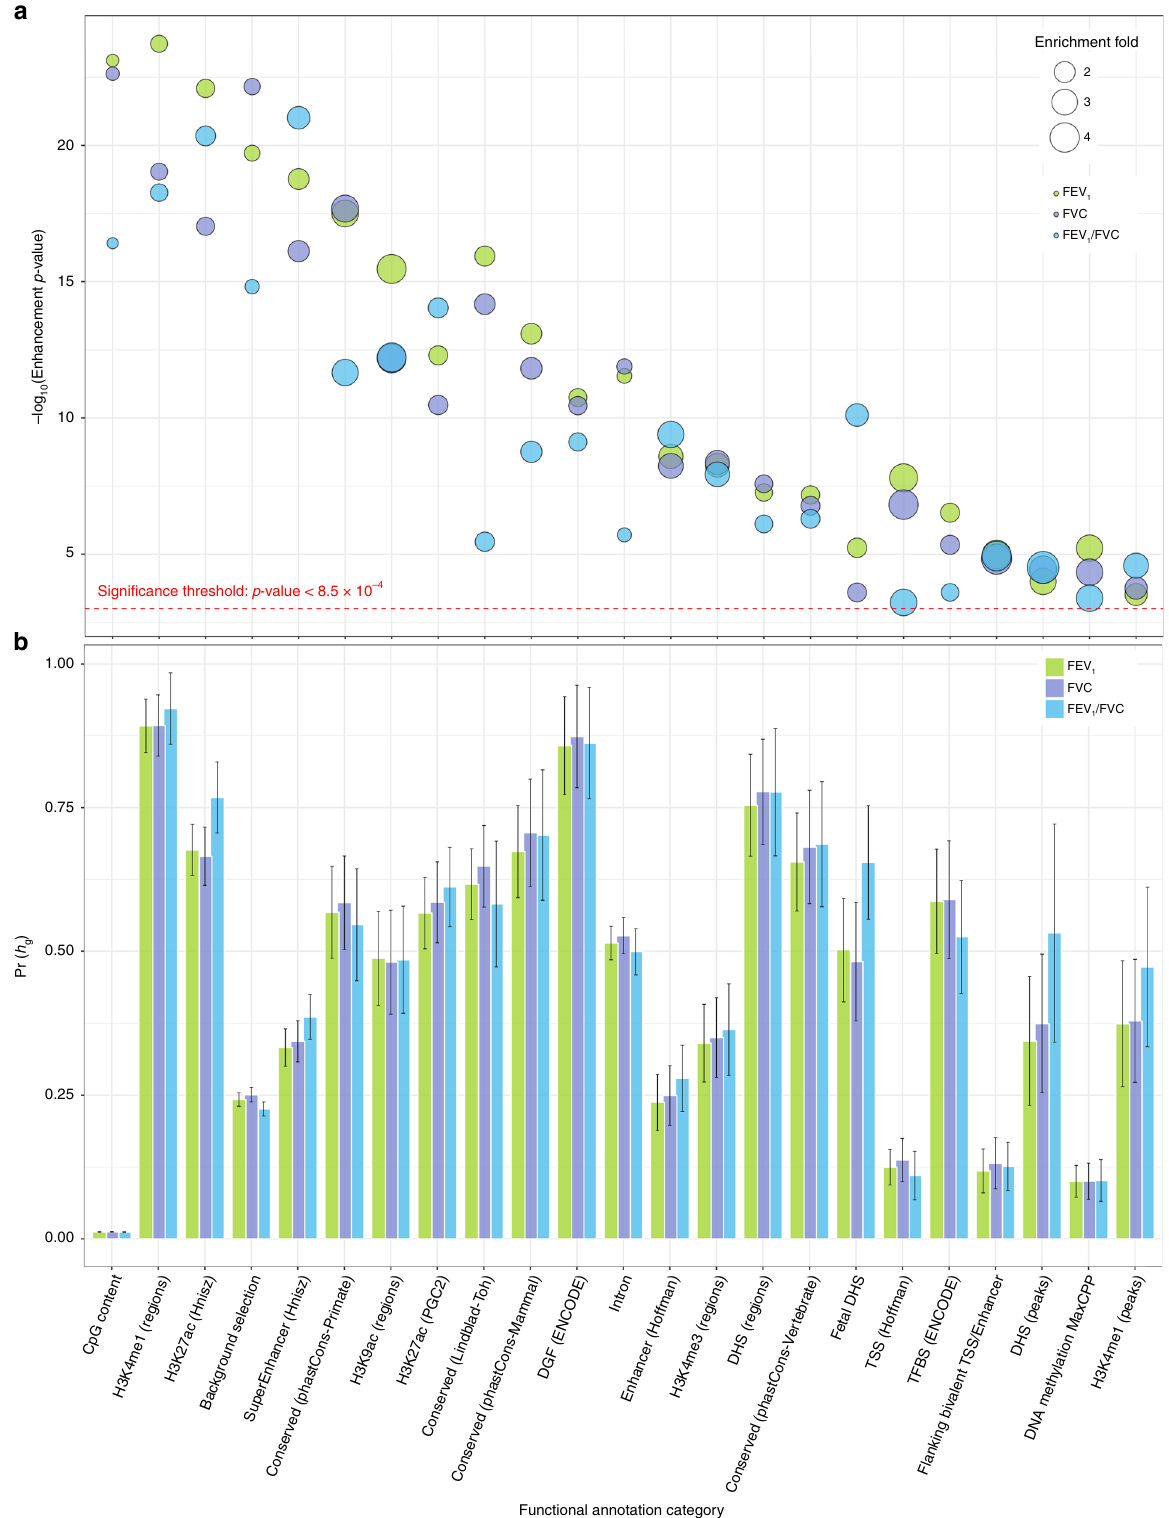
Fig. 1 Functional partitioning of array-based heritability for each pulmonary function phenotype. a The magnitude of category-speci fi c enrichment and corresponding − log 10 ( p -value) for 22 distinct functional annotations that were signi fi cantly enriched for all three phenotypes (FEV 1 , FVC, FEV 1 /FVC). b The proportion of heritability, Pr( h g ), accounted for by each functional annotation with corresponding standard errors. Functional annotation categories are not mutually